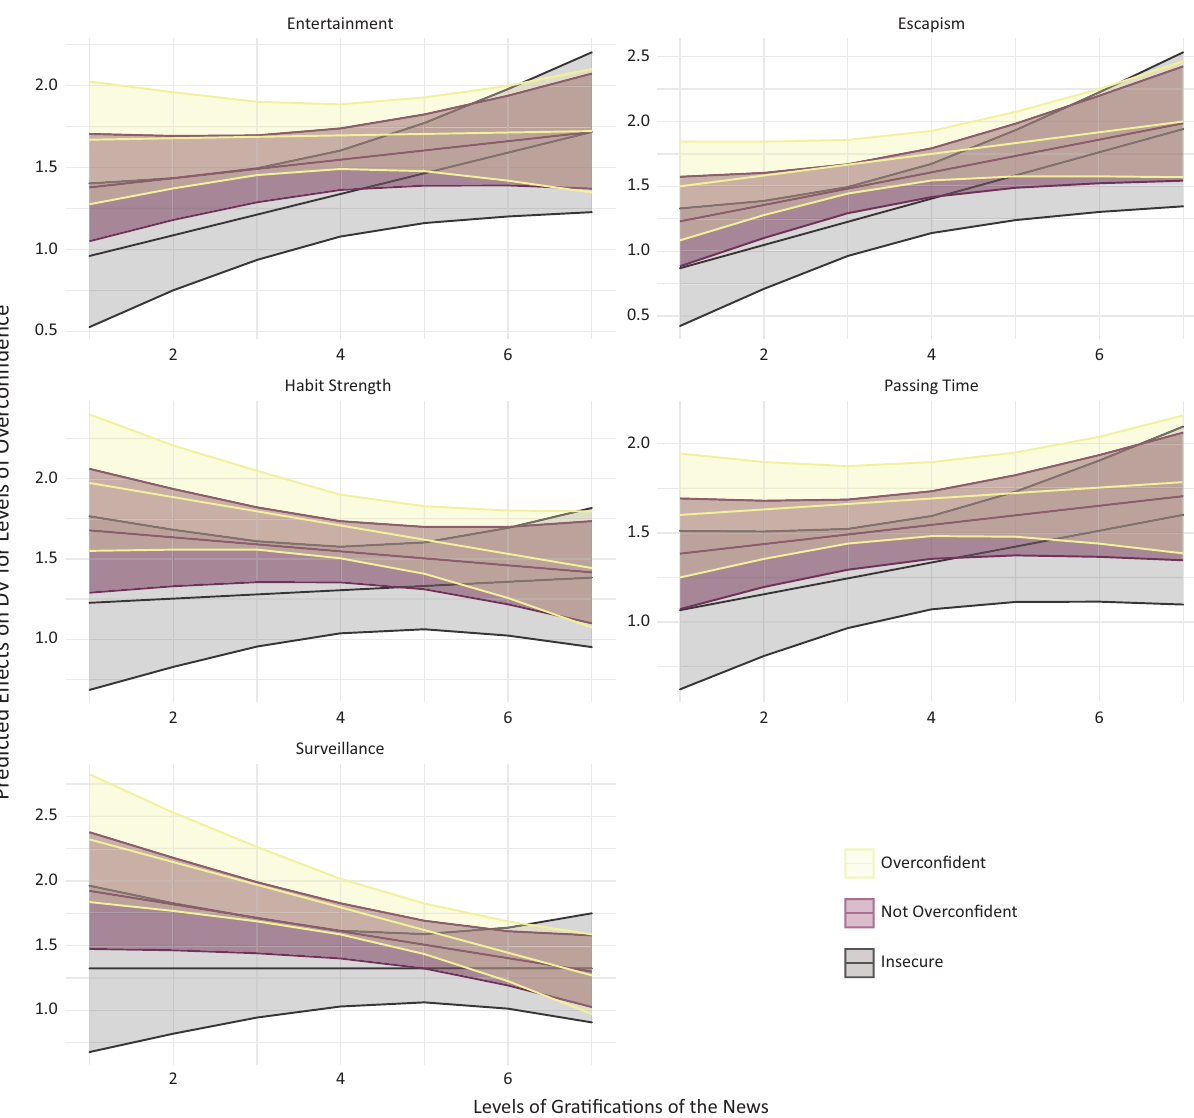
Figure 9. Predicting journalistic appreciation for different levels of epistemic overconfidence. Media and Communication, 2021, Volume 9, Issue 4, Pages